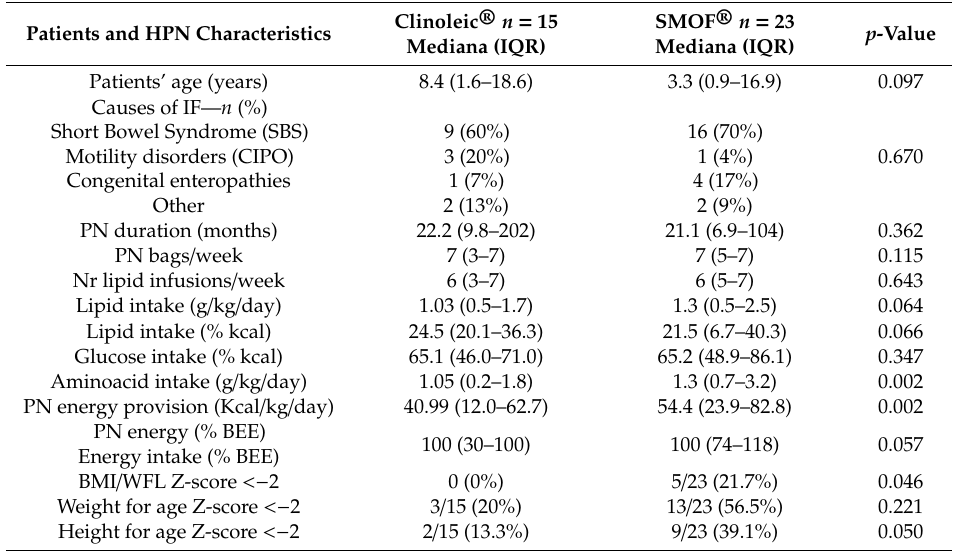
Table 1. Patients and HPN characteristics and patients’ age in both lipid groups. Data expressed as median and interquartile range (IQR).